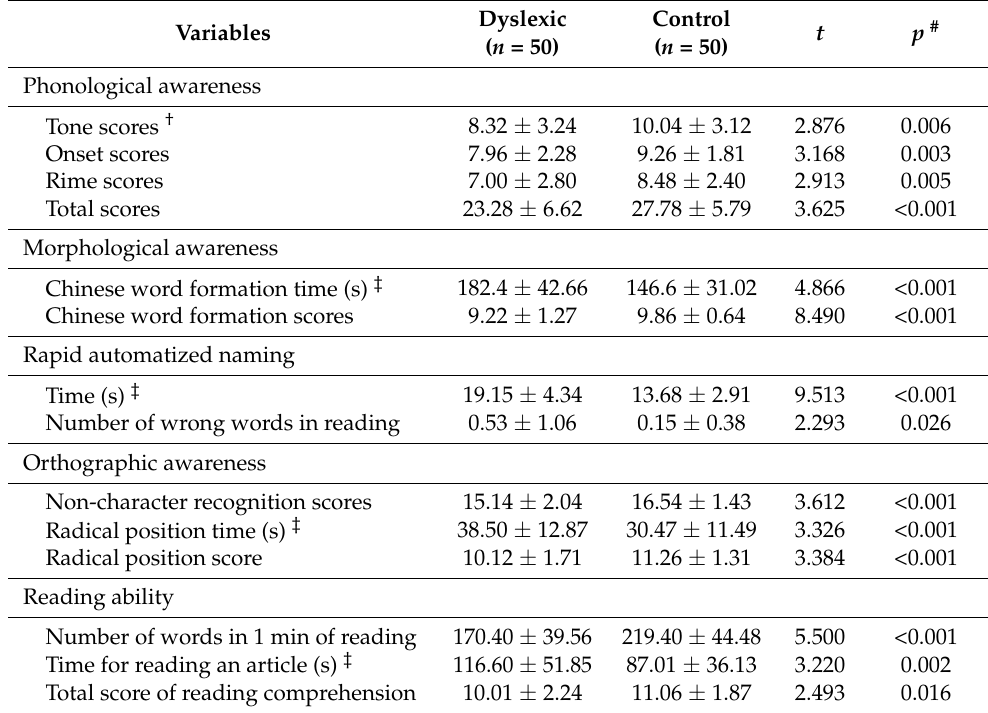
Table 2. Comparison of CRAT between the dyslexic group and the control group. Variables